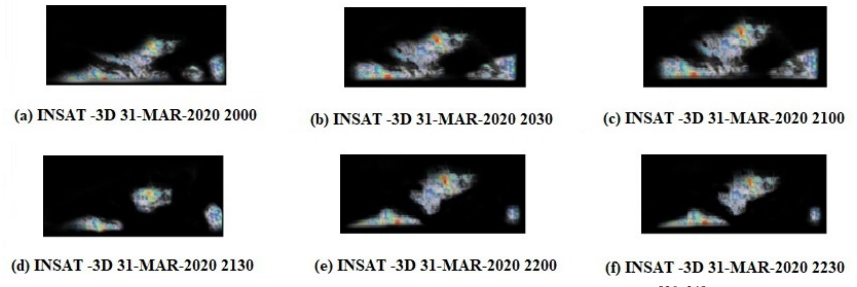
Fig. 5 Normal images in the dataset (sample images) [20,21]